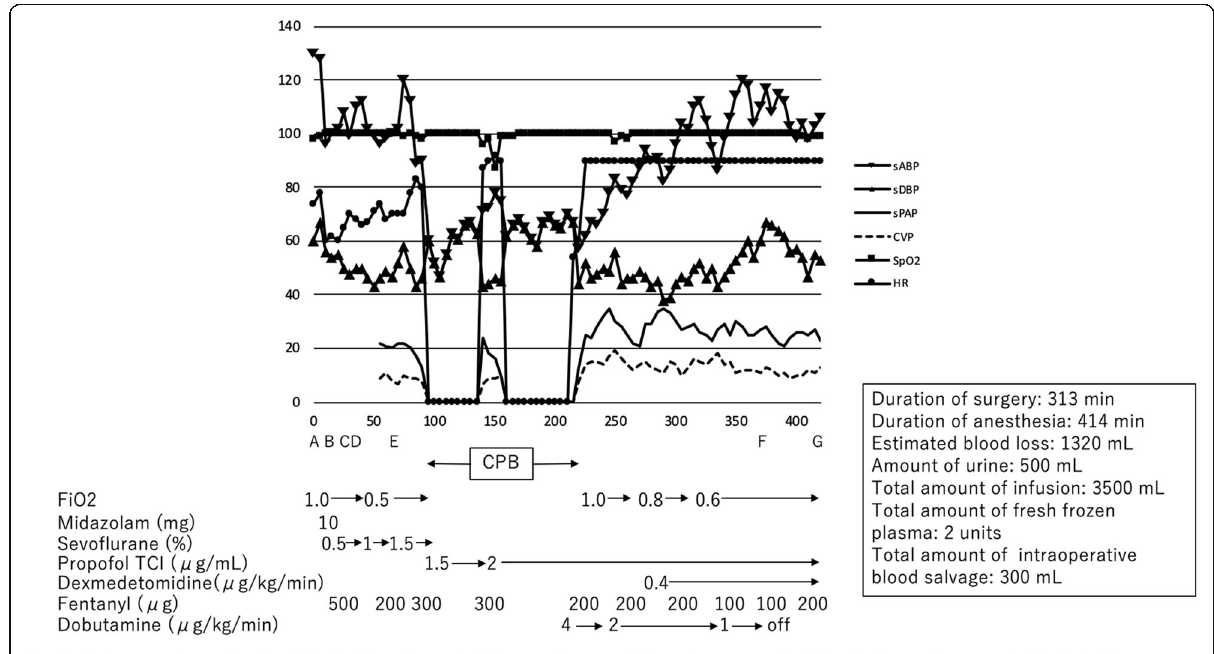
Fig. 3 Intraoperative hemodynamic and respiratory changes during the